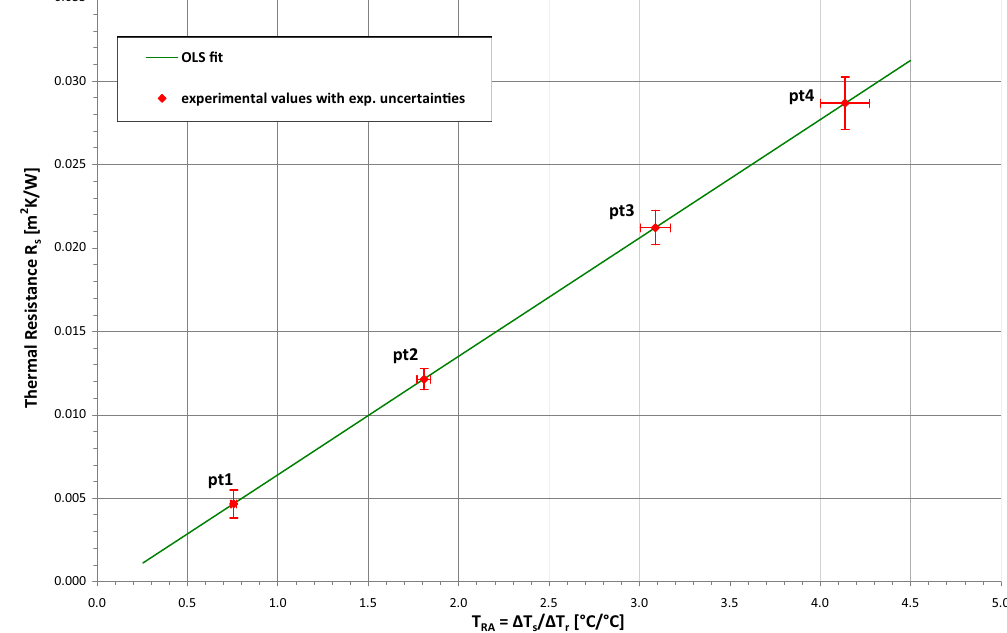
Fig. 6. (Color online) Thermal resistances determined by applying OLS method.